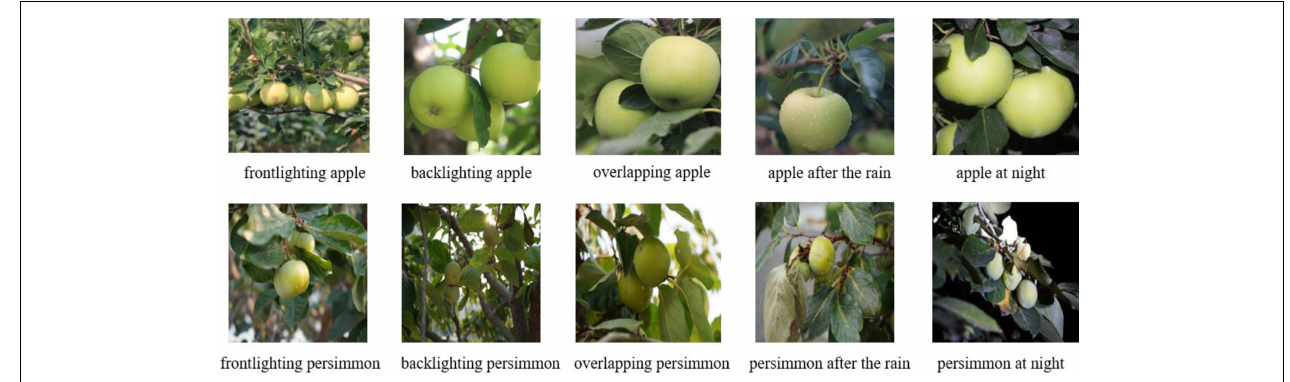
FIGURE 1 | Images of apple and persimmon in front light, backlight, overlap, after rain, and